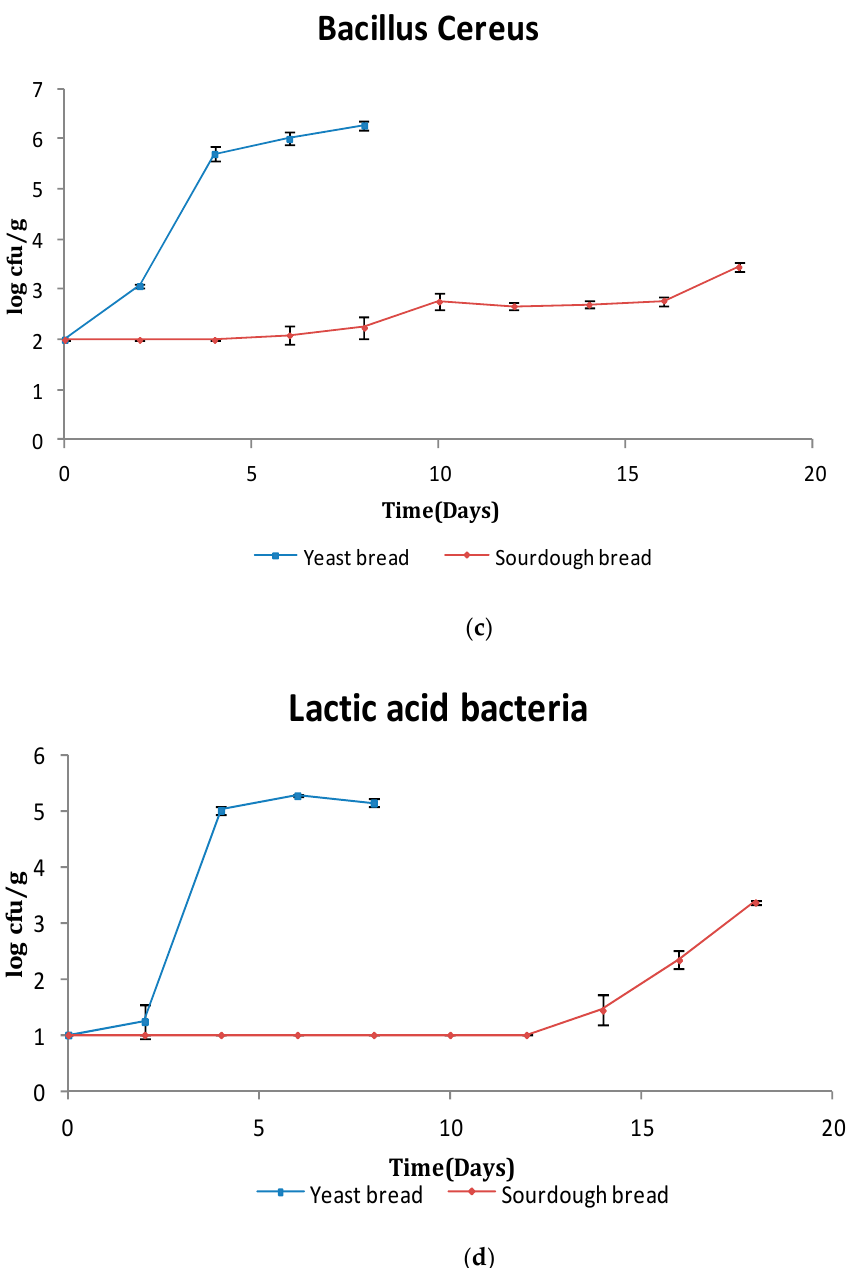
Figure 1. Changes in ( a ) total viable counts (TVC), ( b ) yeasts and molds, ( c ) Bacillus cereus, and ( d ) lactic acid bacteria (LAB) in yeast leavened and sourdough bread as a function of